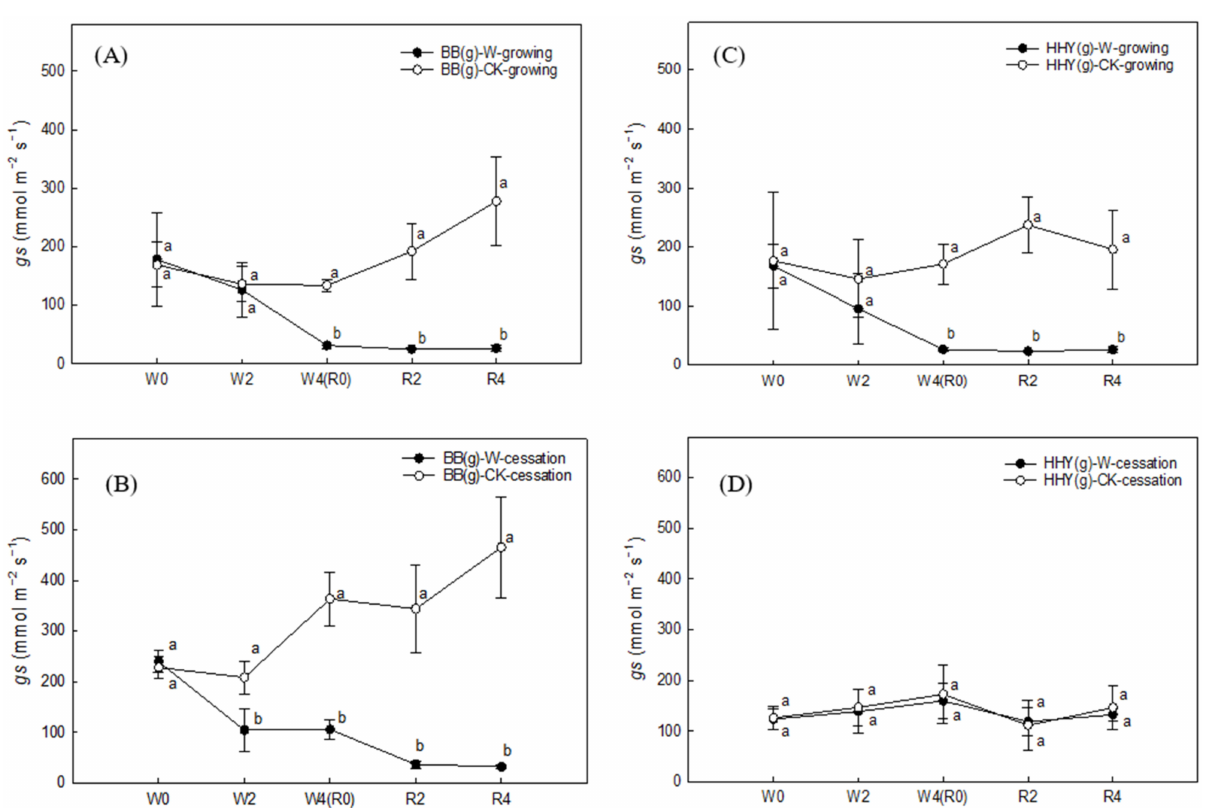
Figure 2. The stomatal conductance (gs) of grafted seedlings of ‘Black-Beauty’ (BB) ( A , B ) and ‘Hung- Hsin-Yuan’ (HHY) ( C , D ) treated with waterlogging (W0, W2, and W4) during the growth period or the growth cessation and continuously investigating the post-waterlogging recovery period (R0, R2, and R4). Bars indicate the standard deviation of three replicates, and the different letters represent the significant difference between the treatments on the same investigated